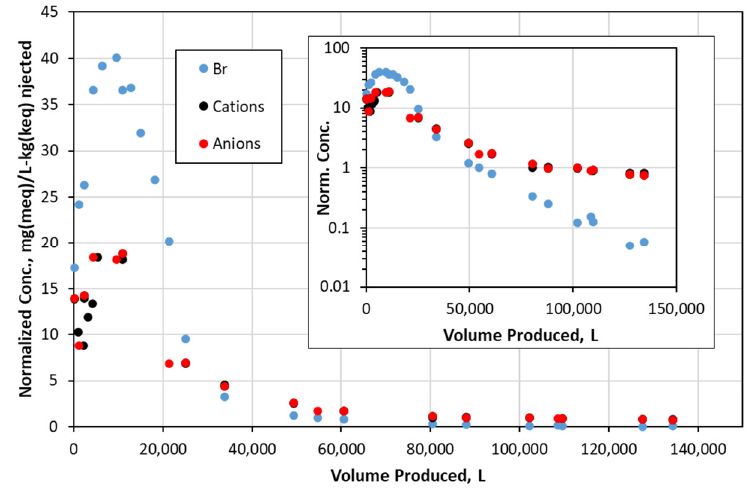
Figure A16. Normalized concentrations of bromide, cation charge, and anion charge as a function of volume produced in the dithionite push-pull test in well 15P-308. Inset plot shows log concentrations.